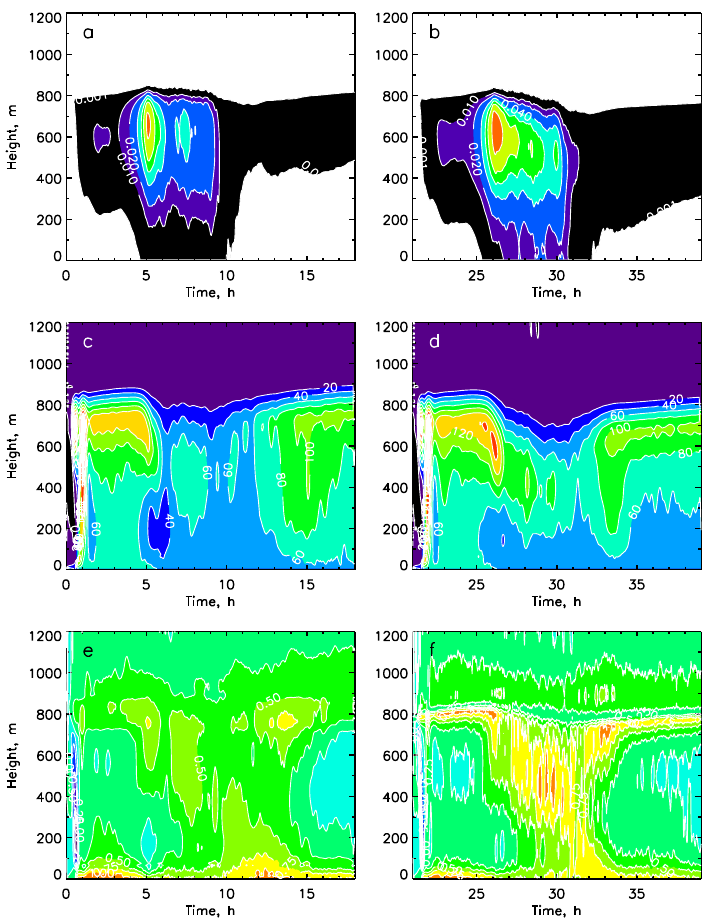
Figure 13. Domain average profiles of (a) and (b) rain water content q r , (c) and (d) q t flux, and (e) and (f) vertical velocity skewness. Left column: control case with minimum N = 5mg − 1 ; right column: RRTM simulation (dashed line in Fig. 12). Stronger drizzle in the RRTM simulation generates stronger positive skewness and higher q t flux during the open-cell period, which help maintain higher f c and LWP (Fig. 12). Contour intervals: rain water content: 0.01, 0.02, 0.04, 0.06, 0.08, 0.12, 0.18gkg − 1 ; q t flux: 20 to 160Wm − 2 in increments of 20; skewness: − 1.5 to 1.5 in increments of 0.25. Color scales are identical for left and right